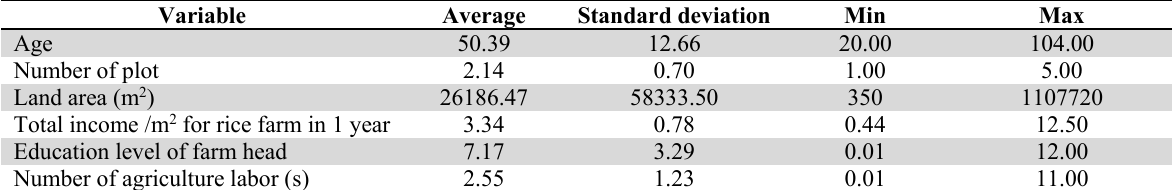
Source: Analysis